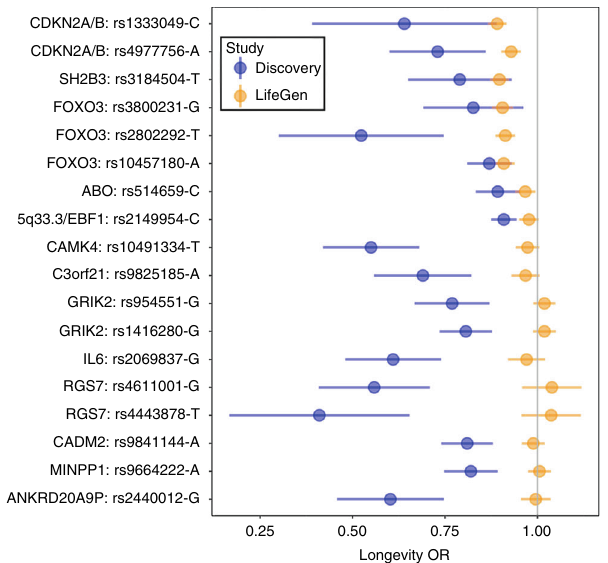
Fig. 3 Validation of associations reported elsewhere by lookup in